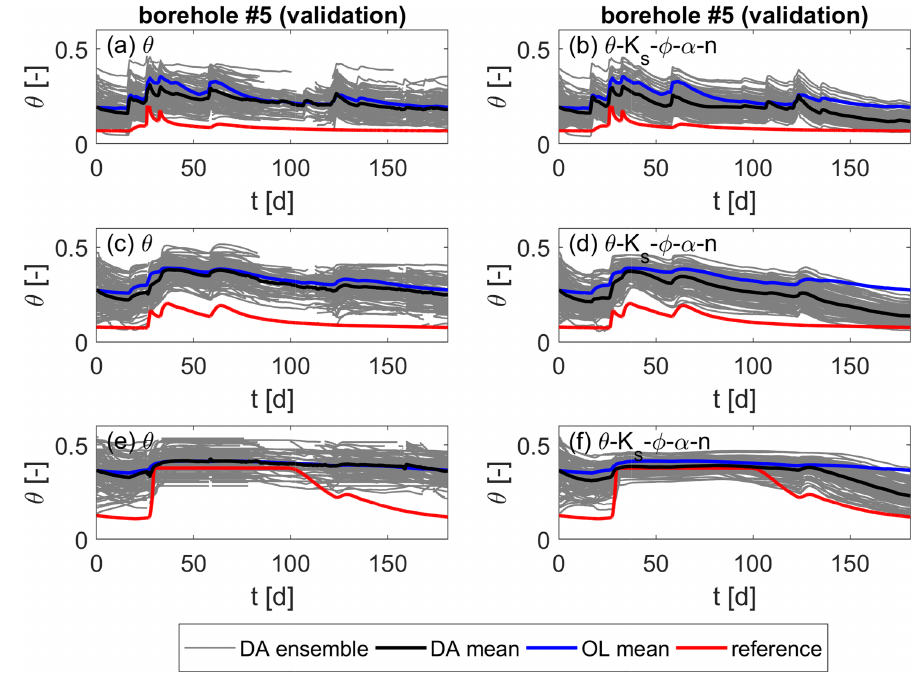
Figure 8. Soil moisture over time for the heterogeneous scenario at one validation location. Values are taken at z 1 = 0 . 33m, z 2 = 0 . 75m, and z 3 = 0 . 95m below the surface from top to bottom. (a, c, e) Updates of soil moisture only. (b, d, f) Joint updates of soil moisture and all